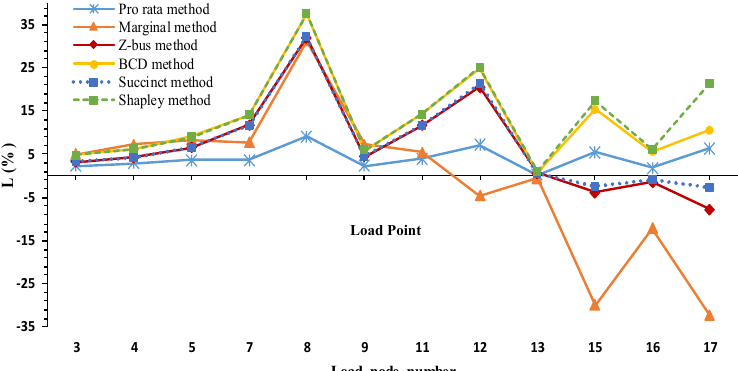
Figure 3. Comparison of different loss allocation techniques to determine the contribution of loads.